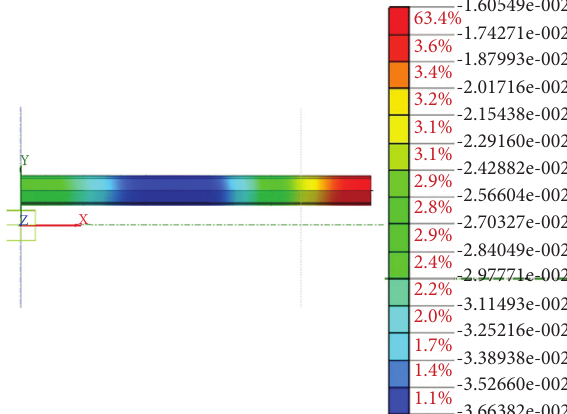
Figure 6: Pipeline deformation cloud